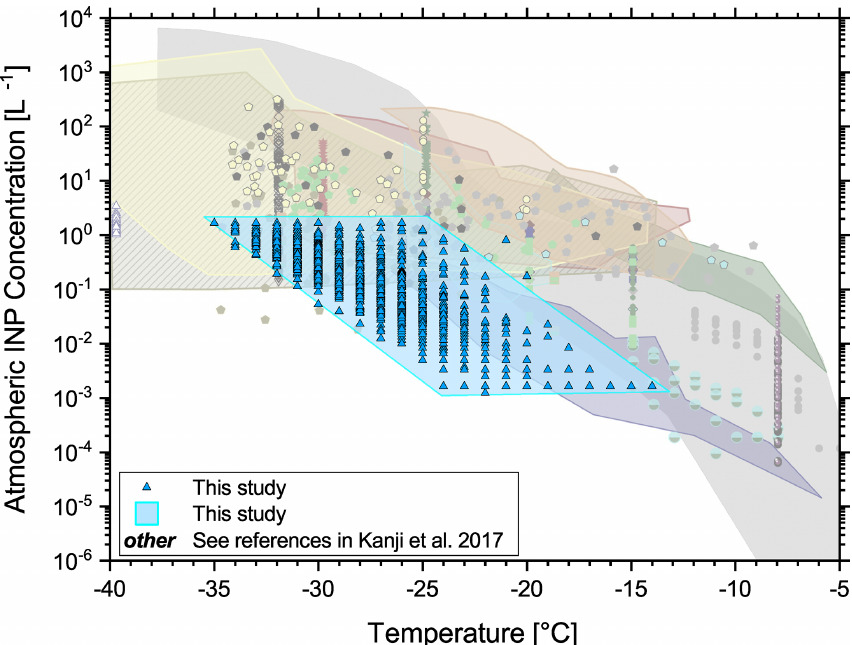
Figure 12. Estimated atmospheric INP concentrations of the ice core samples compared to data from other studies of a diverse set of environments as presented in Kanji et al.